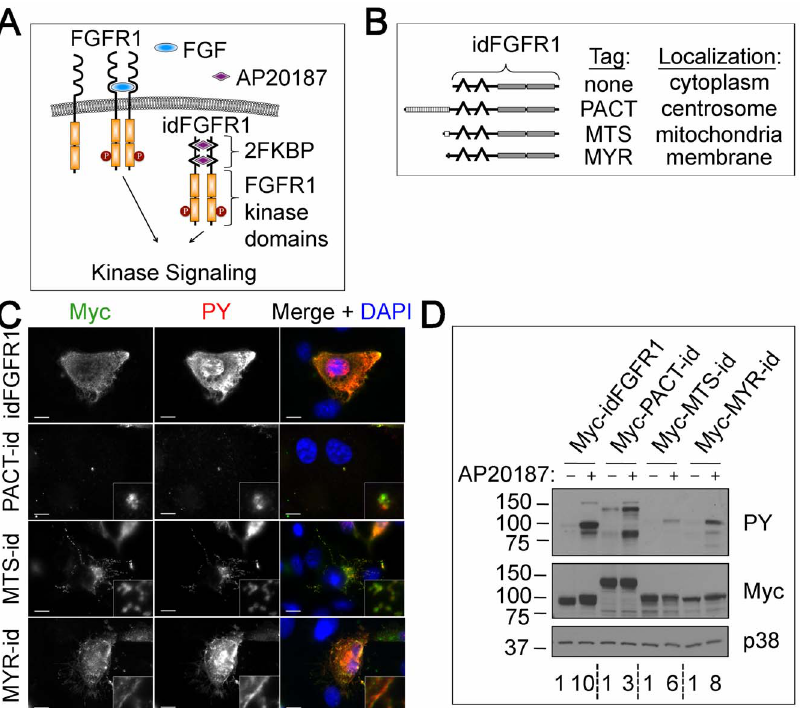
Figure 2. Subcellular targeting of inducibly dimerizable FGFR1 (idFGFR1). ( A ) Schematic of normal FGFR dimerization and idFGFR1 dimerization induced with dimerization ligand AP20187. ( B ) Table of idFGFR1 constructs targeted to subcellular domains by the addition of localization tags. ( C ) RPE-1 cells transfected with Myc-idFGFR1, Myc-PACT-idFGFR1, MTS-idFGFR1-Myc, or MYR-idFGFR1-Myc, treated with 10 nM AP20187 for 24 h, fixed, and stained with antibodies against Myc (green) and PY (red). DNA is stained using DAPI (blue). Scale bars: 10 m m; insets: 10 6 magnification. ( D ) WB analysis of lysates from RPE-1 cells transfected with Myc-idFGFR1, Myc-PACT-idFGFR1, MTS-idFGFR1-Myc, or MYR-idFGFR1-Myc, treated with 10 nM AP20187 or vehicle (100% ethanol) for 24 h in low serum medium, harvested, and probed with antibodies against PY, Myc, and p38 as a loading control. Quantification of PY increase relative to control, normalized by Myc, for each construct is indicated.